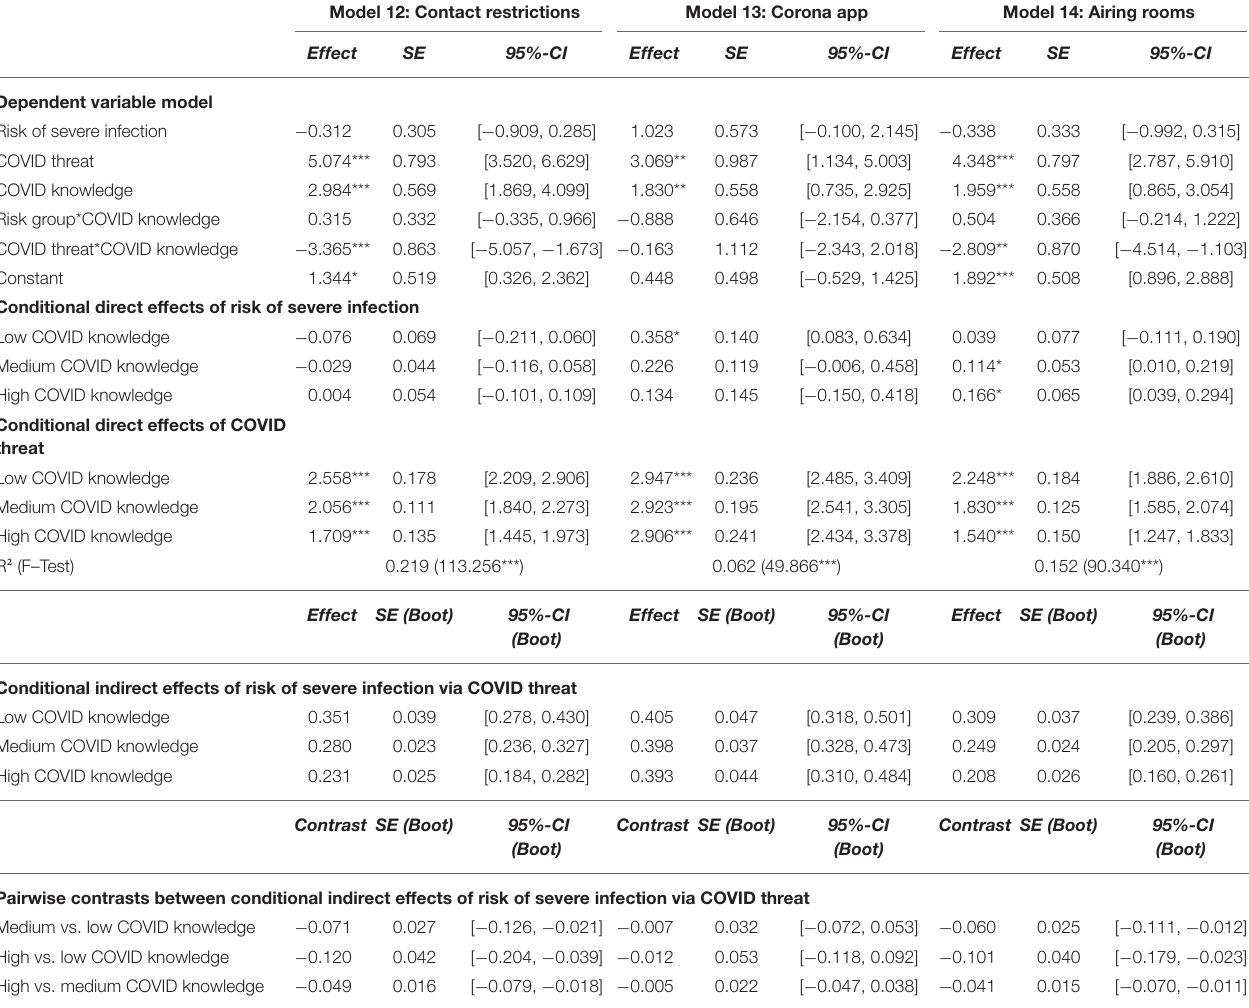
TABLE 7 | Dependent variable model of the conditional mediation model ( N = 4,096) a . Model 12: Contact